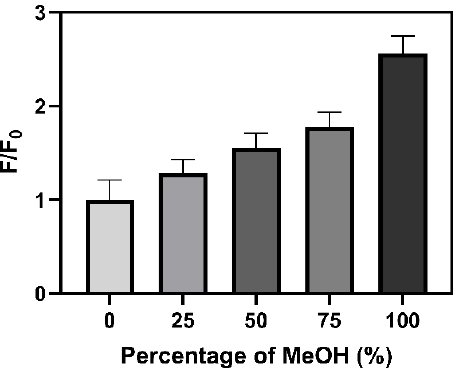
Figure 5. Variation in Br-Clmd fluorescence intensity (F/F 0 ) in mixtures of water and MeOH (from 0 to 100%).